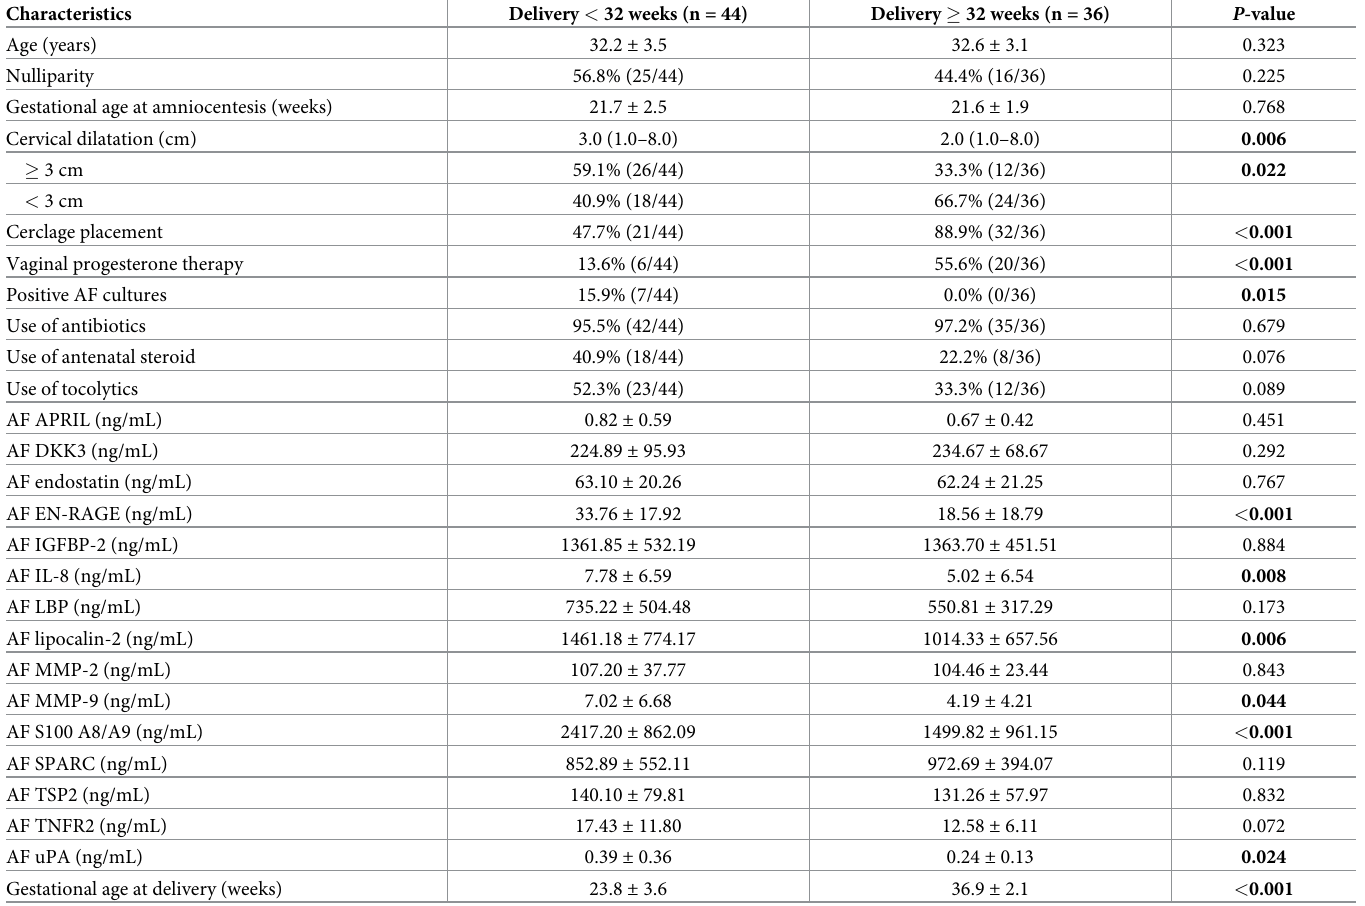
Table 2. Demographic and clinical characteristics, and quantification of the selected candidate biomarkers of interest in women with cervical insufficiency strati- fied according to the occurrence of spontaneous preterm birth.